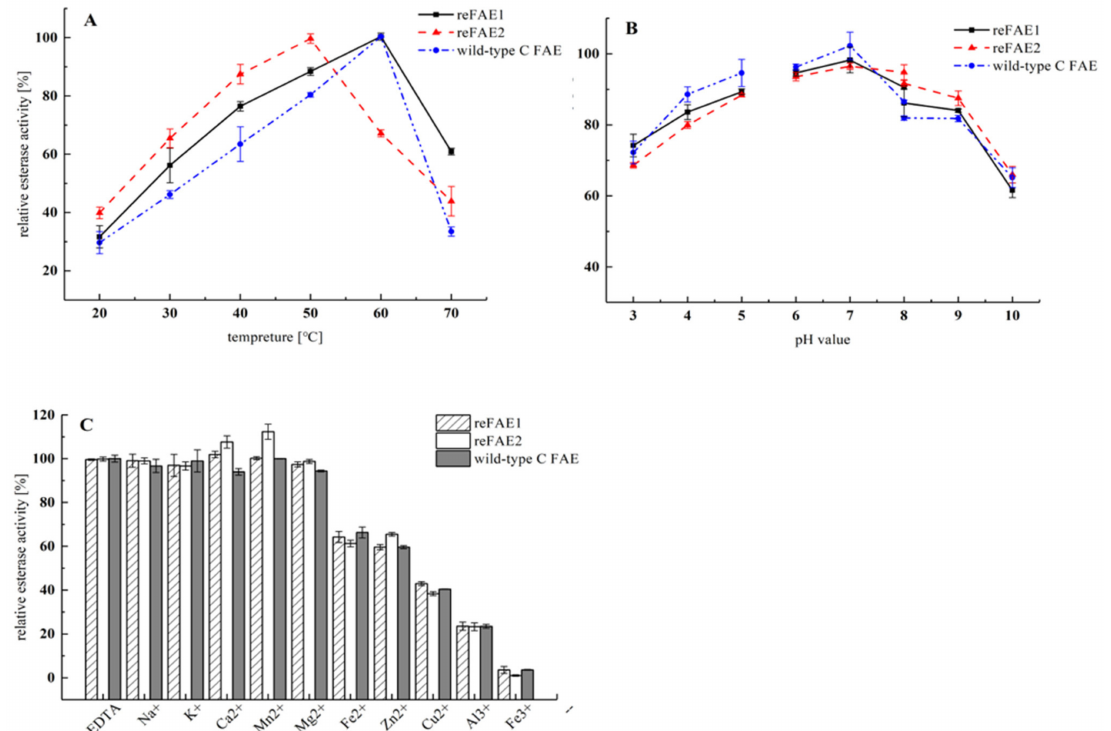
Figure 4. ( A ) Effect of temperature on the CGA hydrolysis activity of recombinant proteins and WTC FAE; ( B ) effect of pH on the CGA hydrolysis activity of recombinant proteins and WTC C FAE. For different pH conditions, different buffer solutions are used: sodium citrate buffer for pH 3–5, phosphate buffer for pH 6–8, and glycine-NaOH buffer for pH 8–10. ( C ) Effect of metal ions on the activity of recombinant